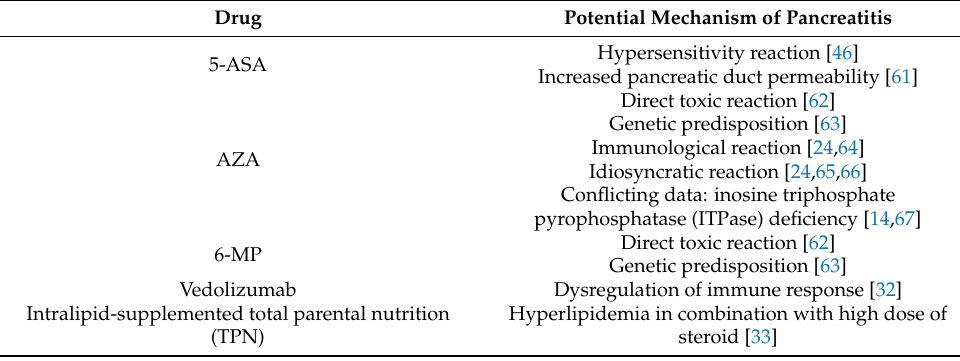
Table 3. Potential mechanisms of drug-induced